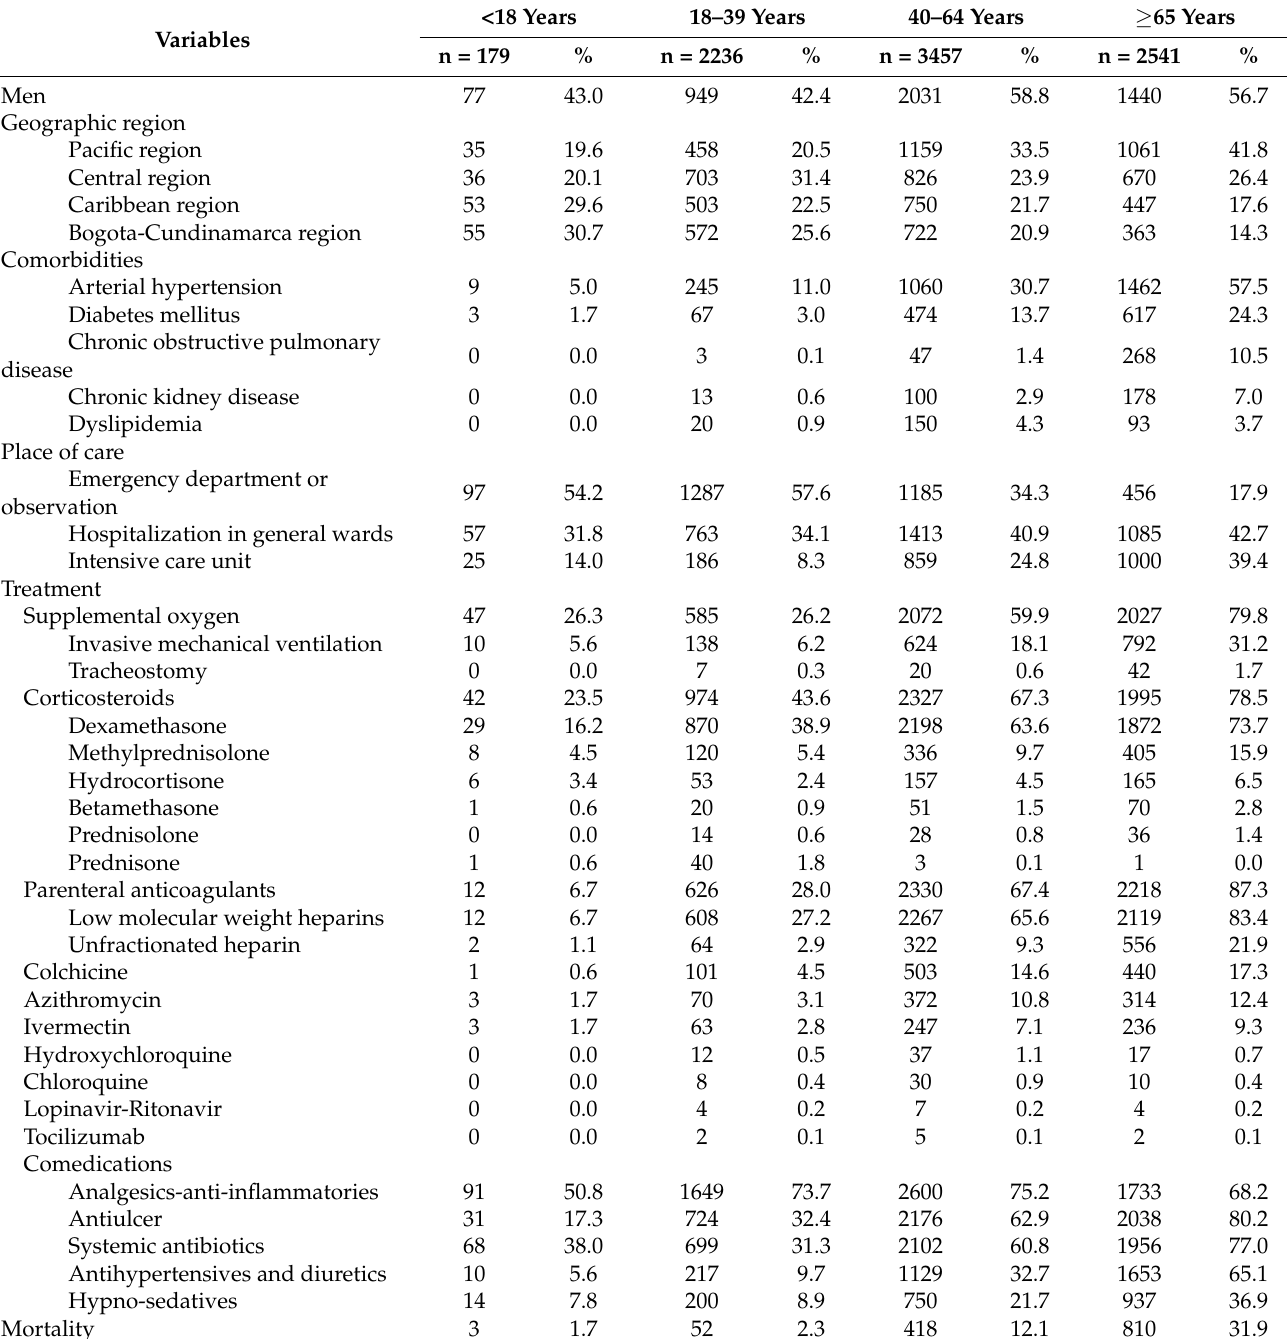
Table 2. Comparison of some sociodemographic, clinical and pharmacological variables by age, in a group of patients with a confirmed diagnosis of SARS-CoV-2 infection,